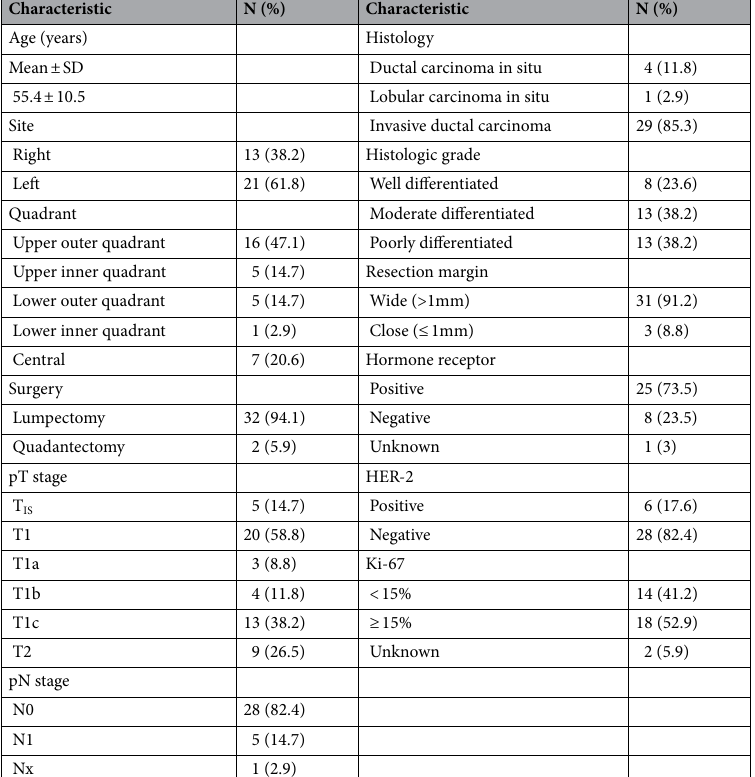
Table 1. Baseline patient and tumor characteristics.